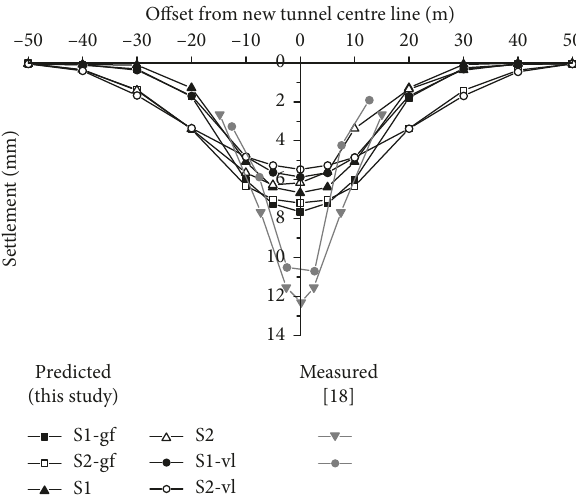
Figure 7: Comparison of transverse ground surface settlement troughs.